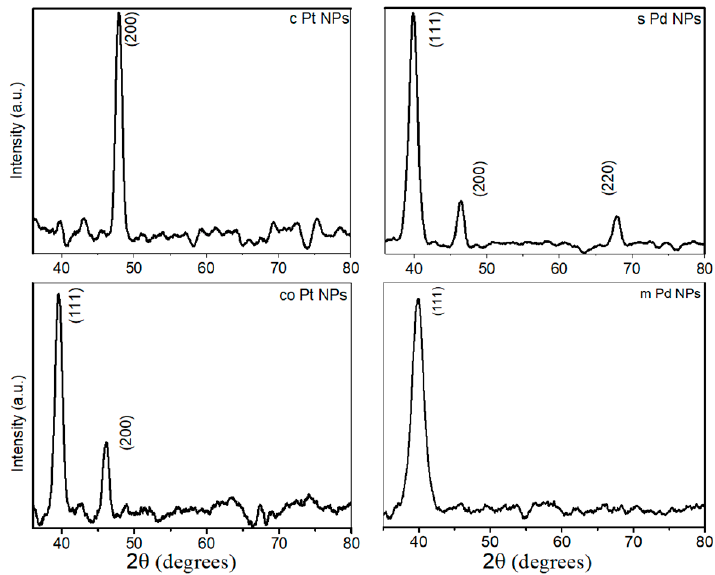
Figure 6. The XRD Patterns of the NPs (supported on SBA-15 ).